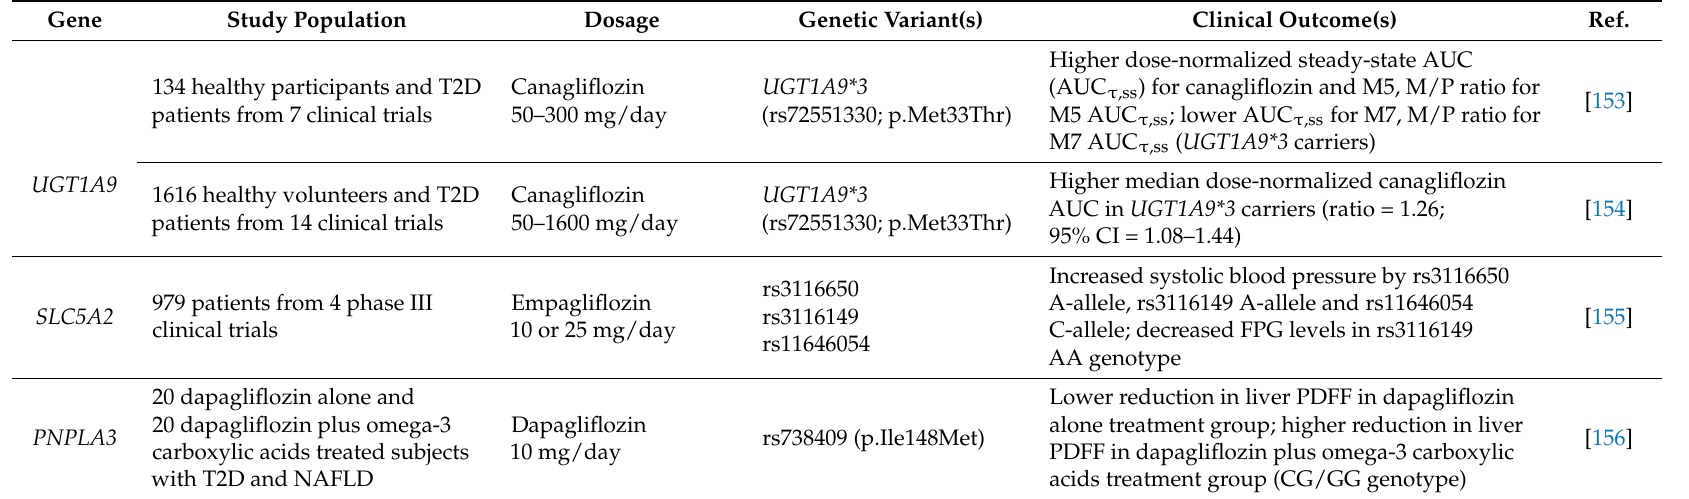
Table 4. Genes associated with responses to sodium-glucose cotransporter-2 (SGLT2)